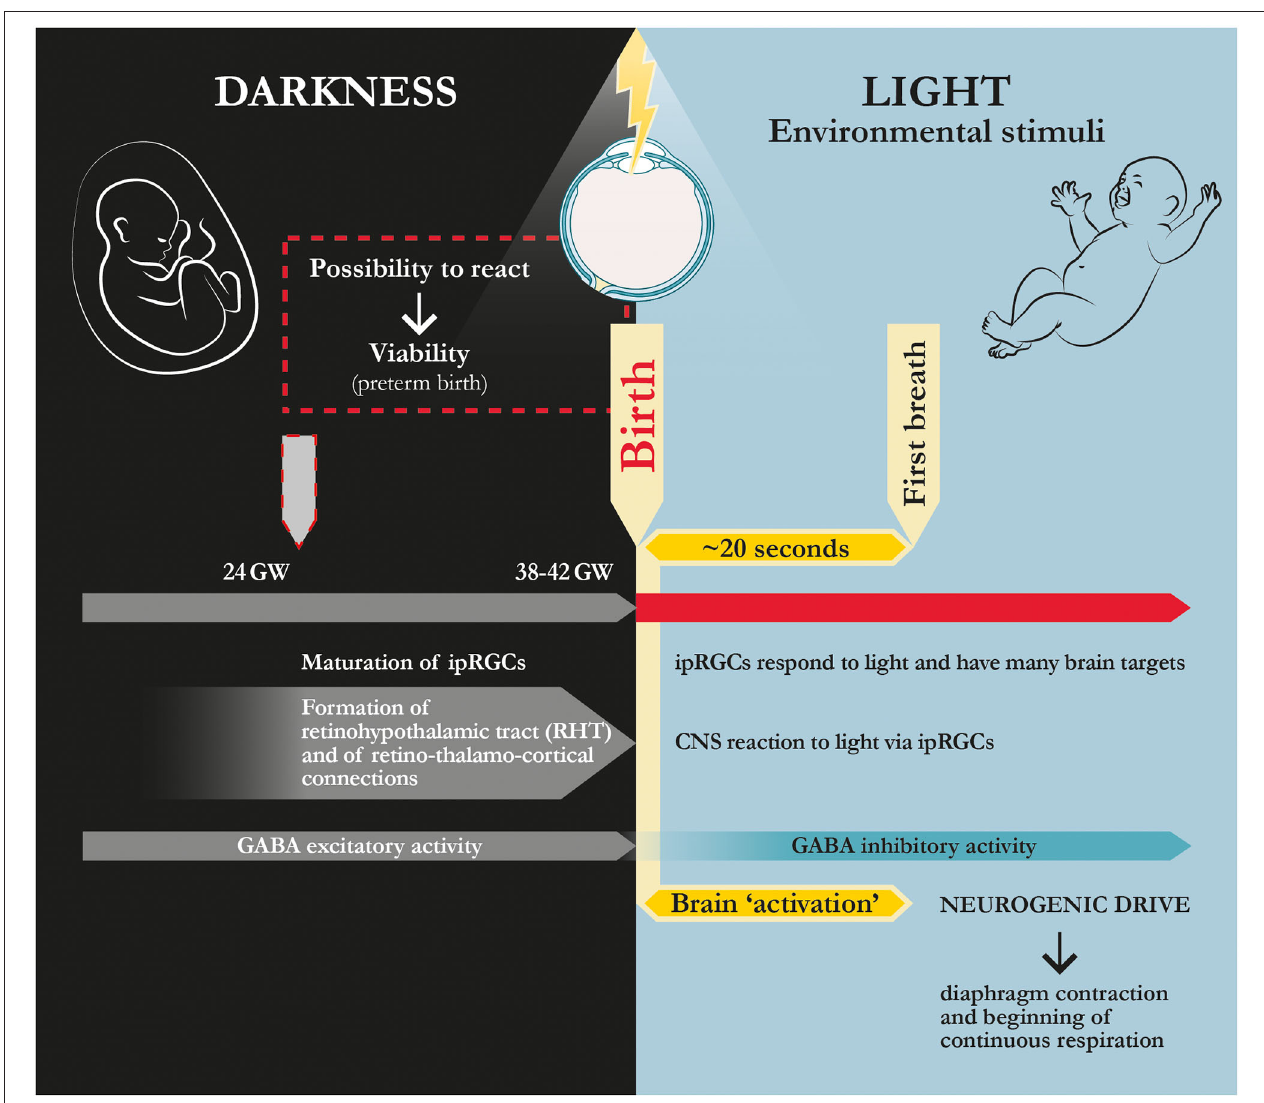
FIGURE 3 | Physiological dynamics at human birth: ‘coming to light.’ In humans, the fetus becomes viable at ∼ 24th gestational week when retinohypothalamic tract (RHT) and retino-thalamo-cortical connections are formed ( Hevner, 2000; Gatti et al., 2012; Fagioli, 2019). According to this hypothesis and theory article, maturation of these pathways allows for the transferal of the signal induced by light/photon stimulus from retinal active photoreceptors (ipRGCs) to the whole brain, thereby rapidly activating respiratory nuclei and driving the first breath. GW, gestational weeks; ipRGCs, intrinsically photosensitive retinal ganglion